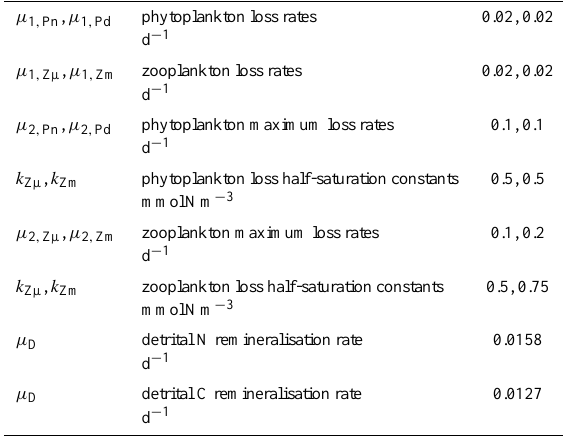
Table 3. Plankton and detritus loss